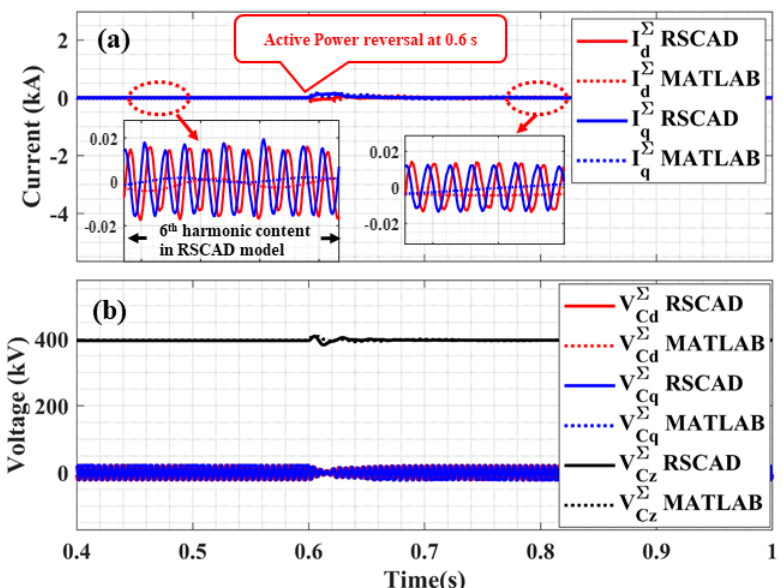
Figure 11. Comparison of: ( a ) circulating currents i Σ voltage in the dqz reference frame; in MATLAB (blue) and RSCAD (red) during active power reversal from 1 p.u. to -1 p.u. at the time instance t = 0.6